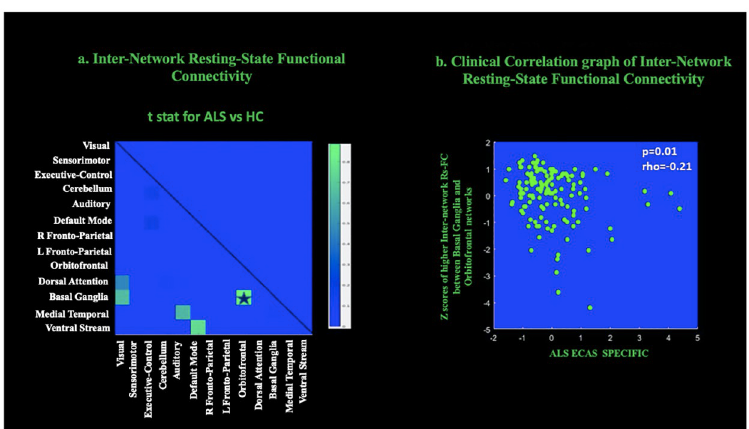
Fig 4. The t-test comparisons between the matrixes of partial correlation obtained from the time course series of 13 resting-state networks (RSNs) obtained from the whole group of participants. a: Higher inter-network resting- state functional connectivity (Rs-FC) between basal ganglia RSN and orbitofrontal RSN (Corrected for multiple comparisons using the family-wise error approach at p < 0.05). b: Negative correlation between increased Rs-FC between basal ganglia RSN and orbitofrontal RSN and ECAS ALS Specific score (Spearmen rank correlation; [p = 0.01; r s = -0.21]). Star: Higher Rs-FC in ALS patients than healthy subjects (HC).